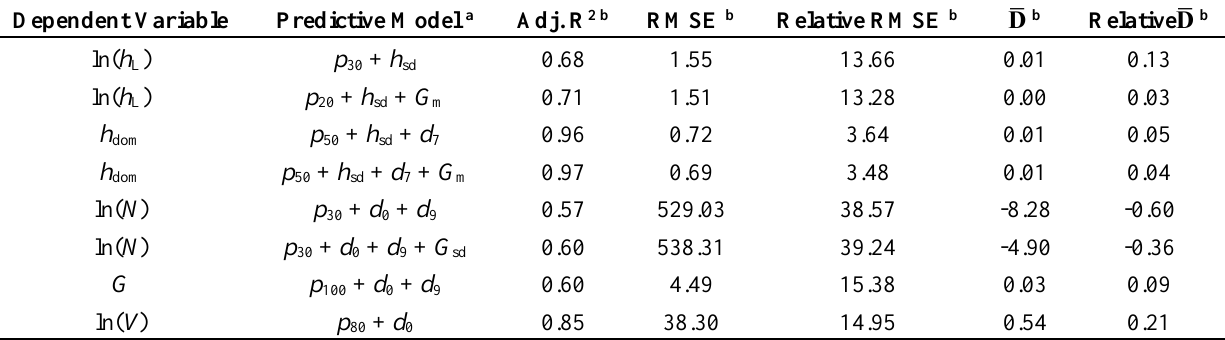
Table 4. Summary of the regression analysis for Lorey’s mean height ( h L ), dominant height ( h dom ), stem number ( N ), basal area ( G ), and stem volume ( V ). Logarithmic transformations were used for h L , N , and V . For the models where spectral variables were selected, the alternative model (without spectral variables) was also